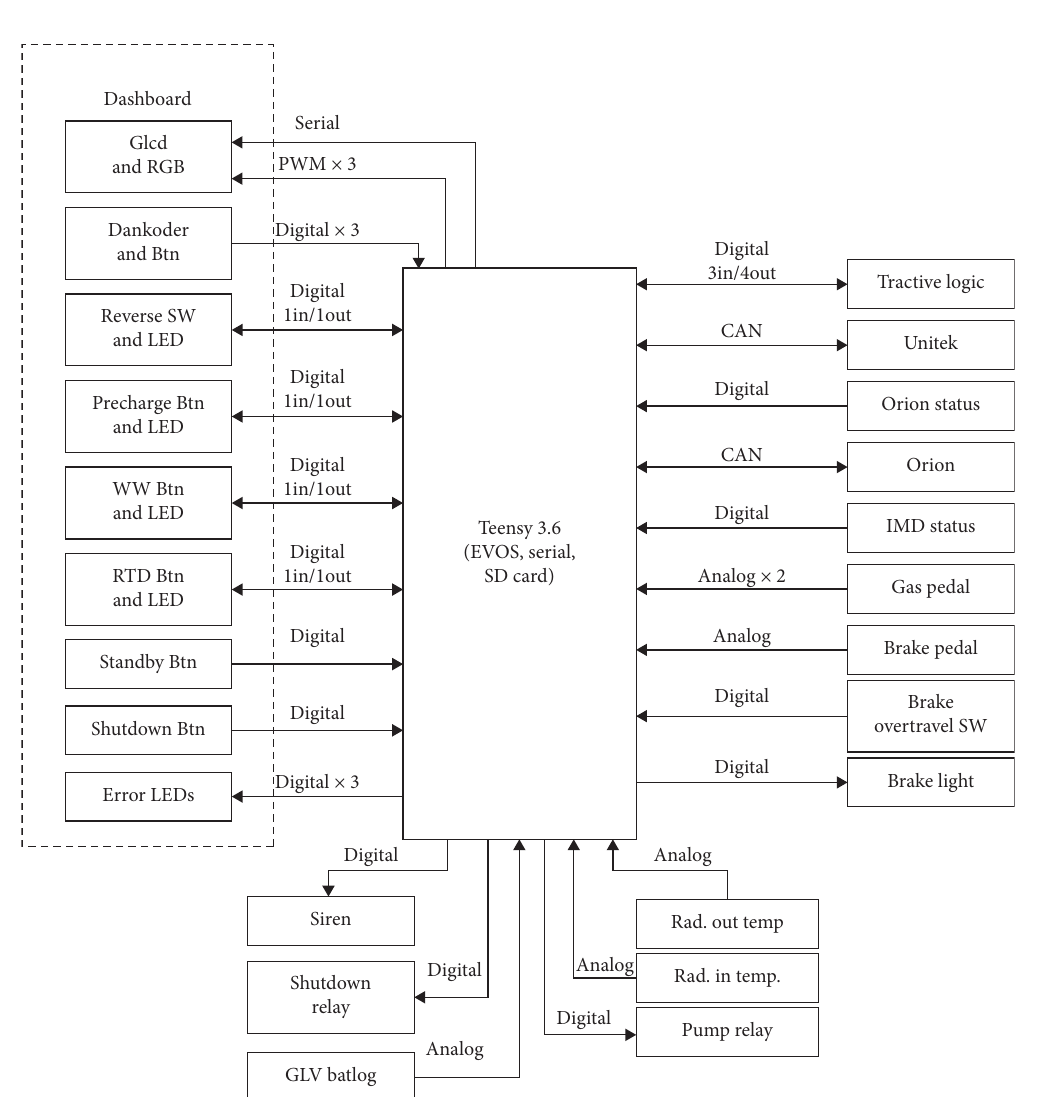
Figure 8: Logical connections of hardware for Teensy 3.6.